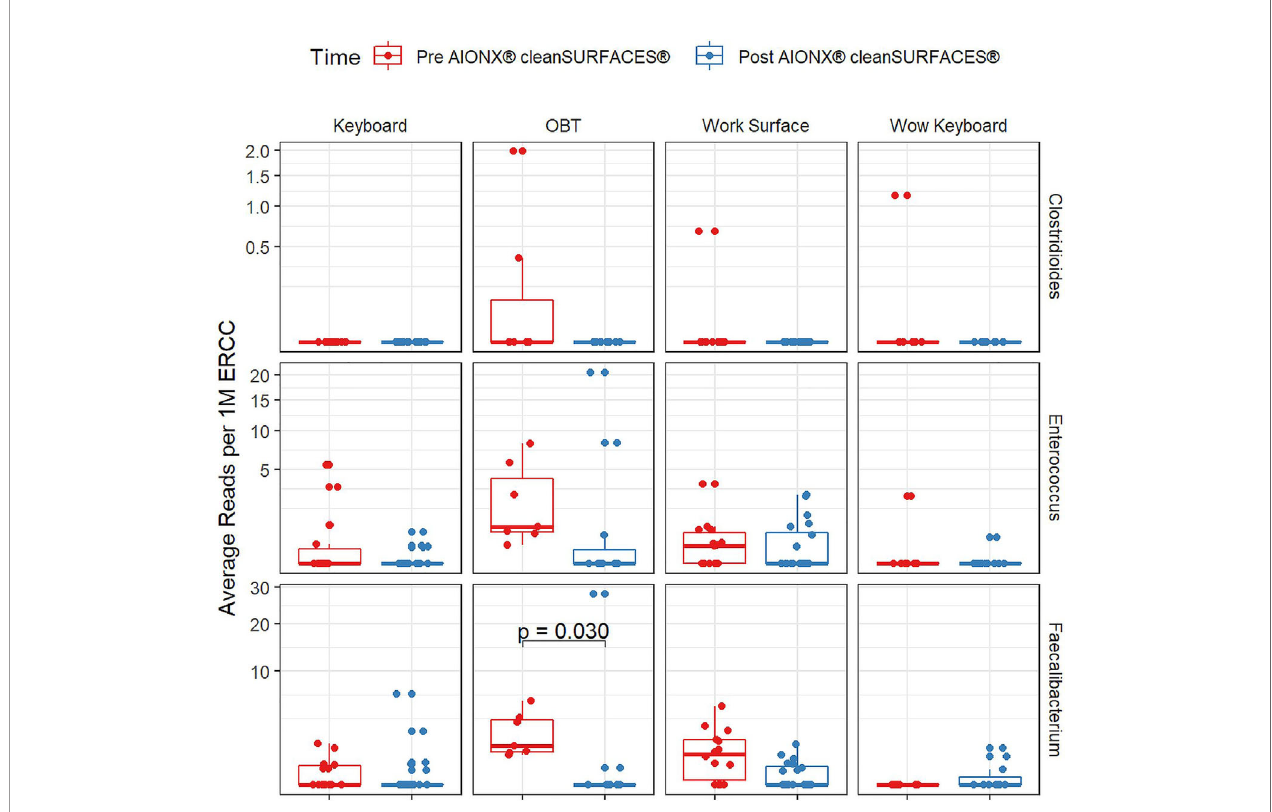
FIGURE 8 | Normalized average transcript count comparison boxplot of fecal biomarker taxa between surfaces before and after the intervention of the AIONX ® cleanSURFACES ® . Statistically signi fi cant (adjusted p < 0.05) comparisons are marked with an